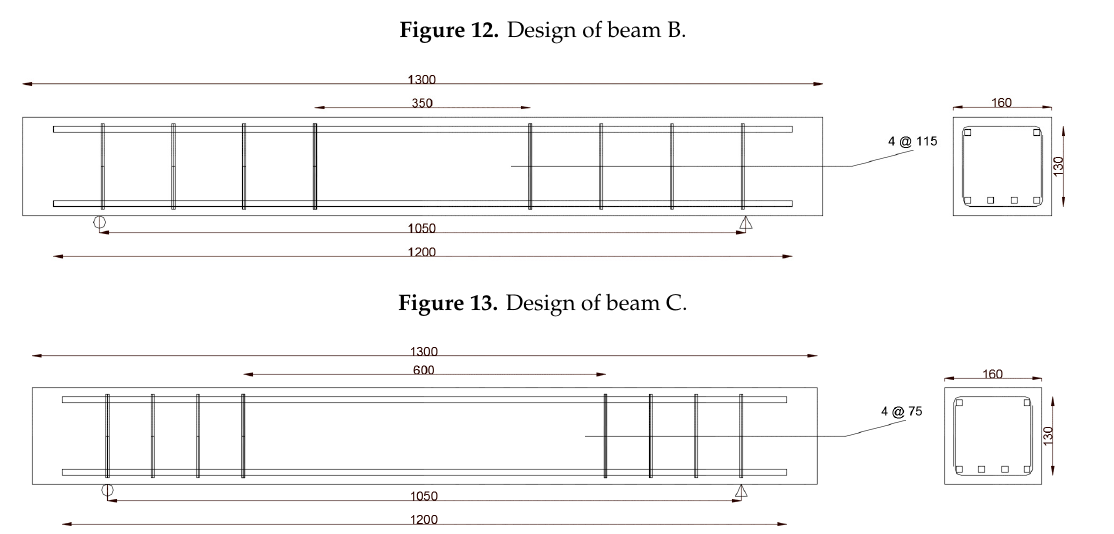
Figure 12. Design of beam B.